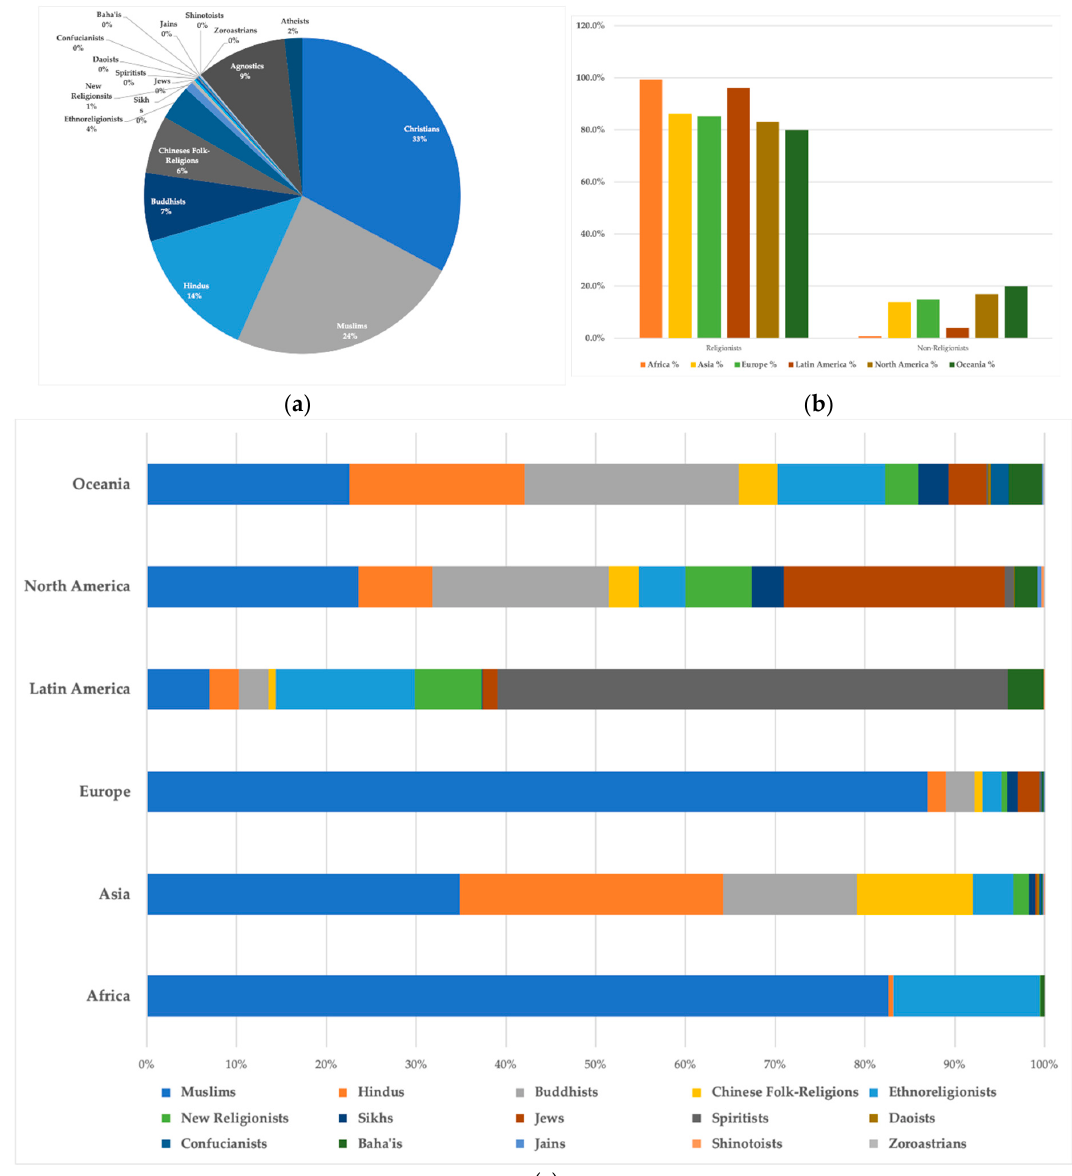
Figure 4. Religious demography: Religious affiliation by continent based on 2017 data reported by Johnson and Crossing (2019b). ( a ) Top left : Pie chart of proportion of population adhering to each world religion. ( b ) Top right : Comparing the absolute size of the ‘religionist population’ to the ‘non-religionists’ population in each continent. ( c ) Bottom : Proportion of non-Christian religious population in each world region.